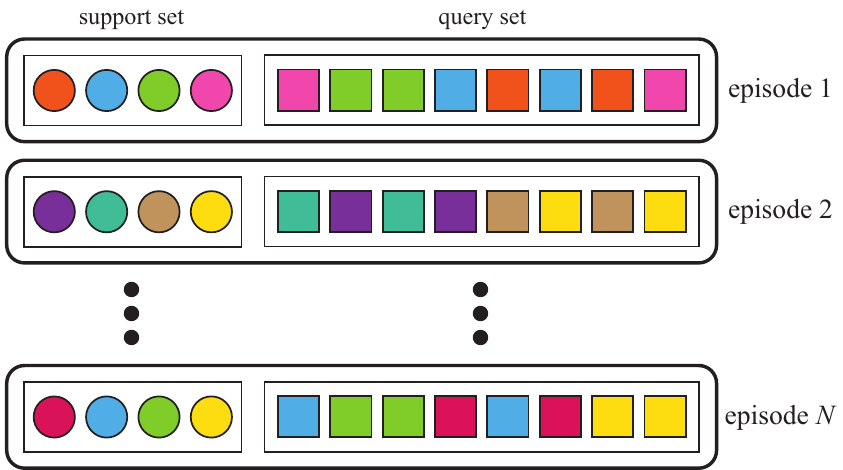
Figure 5. Schematic of episodes (4-way 1-shot 2-query) in the typical meta-learning process. Different colors represent different